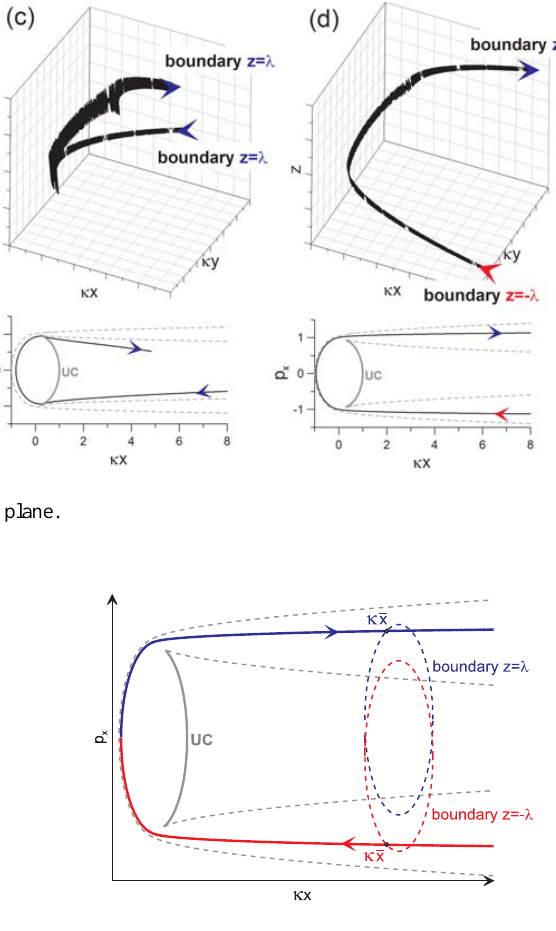
Fig. 5. Schematic view of particle